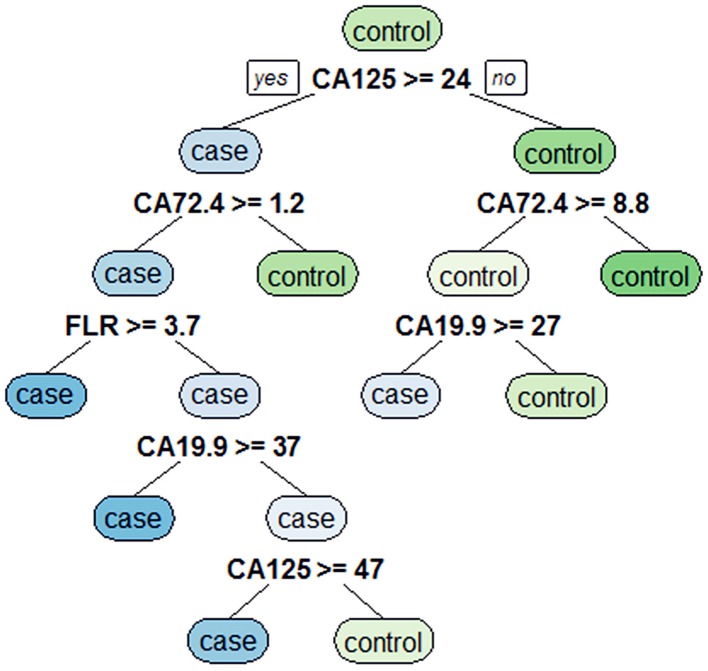
Classification tree for detecting undiagnosed PD in GC.